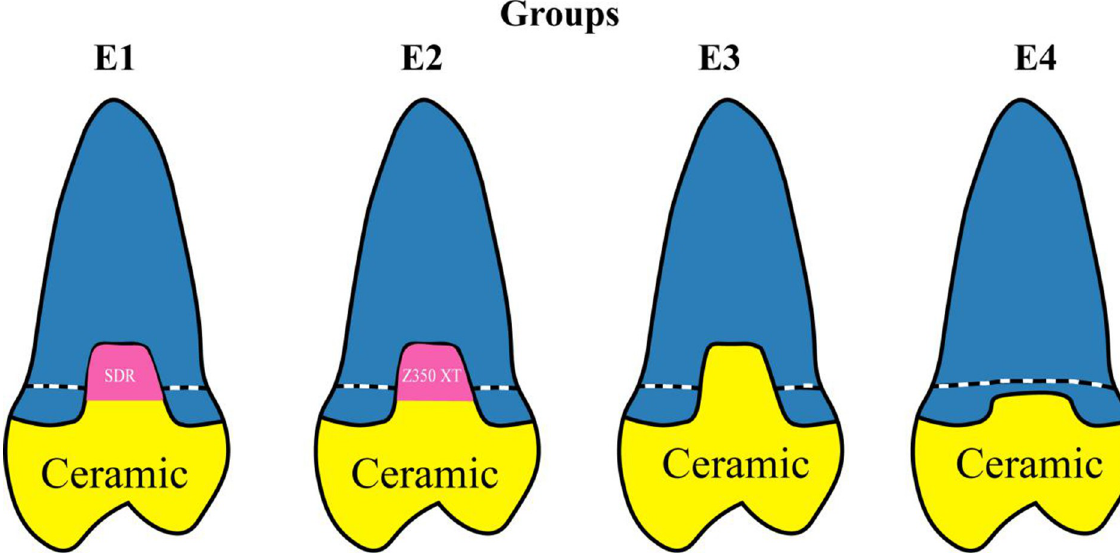
Fig 1. Restoration designs used in this study. Groups E1, E2 and E3, with proximal margins located in dentin/cementum, subgingival. Group E4 (supragingival group), with proximal margins located in enamel above the CEJ, as the positive control. Group E1 was with bulk-fill Smart Dentin Replacement, and E2 with conventional resin composite. Group E3 was treated with a ceramic crown, as the negative control.